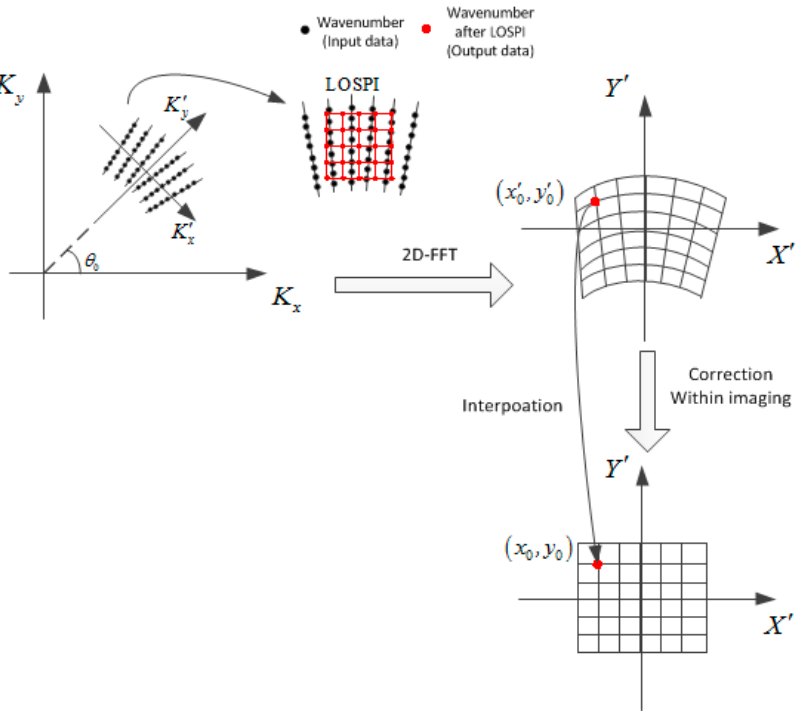
Figure 3. The process of LOSPI and distortion correction.